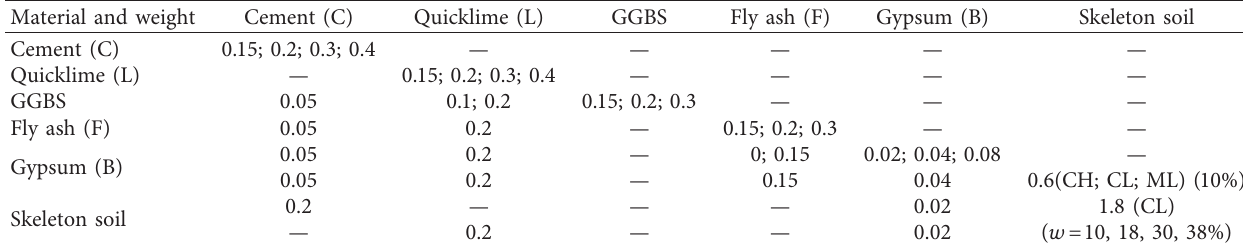
Table 4: Specific program of UCS test (g/g).